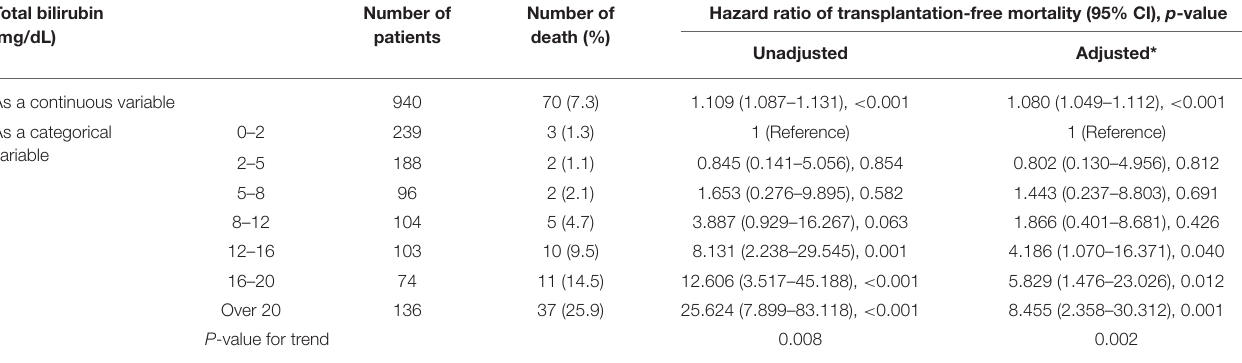
TABLE 4 | The unadjusted and adjusted hazard ratios of 90-day transplantation-free mortality due to total bilirubin in patients with advanced fibrosis. Total bilirubin